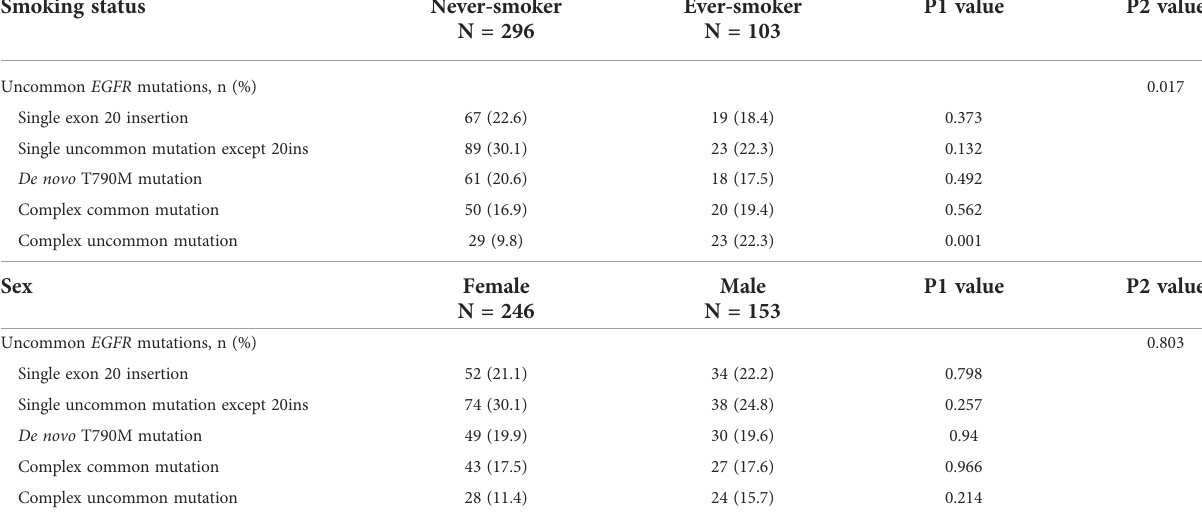
TABLE 4 Frequency of uncommon EGFR mutation types in NSCLC patients with different smoking status and sex.